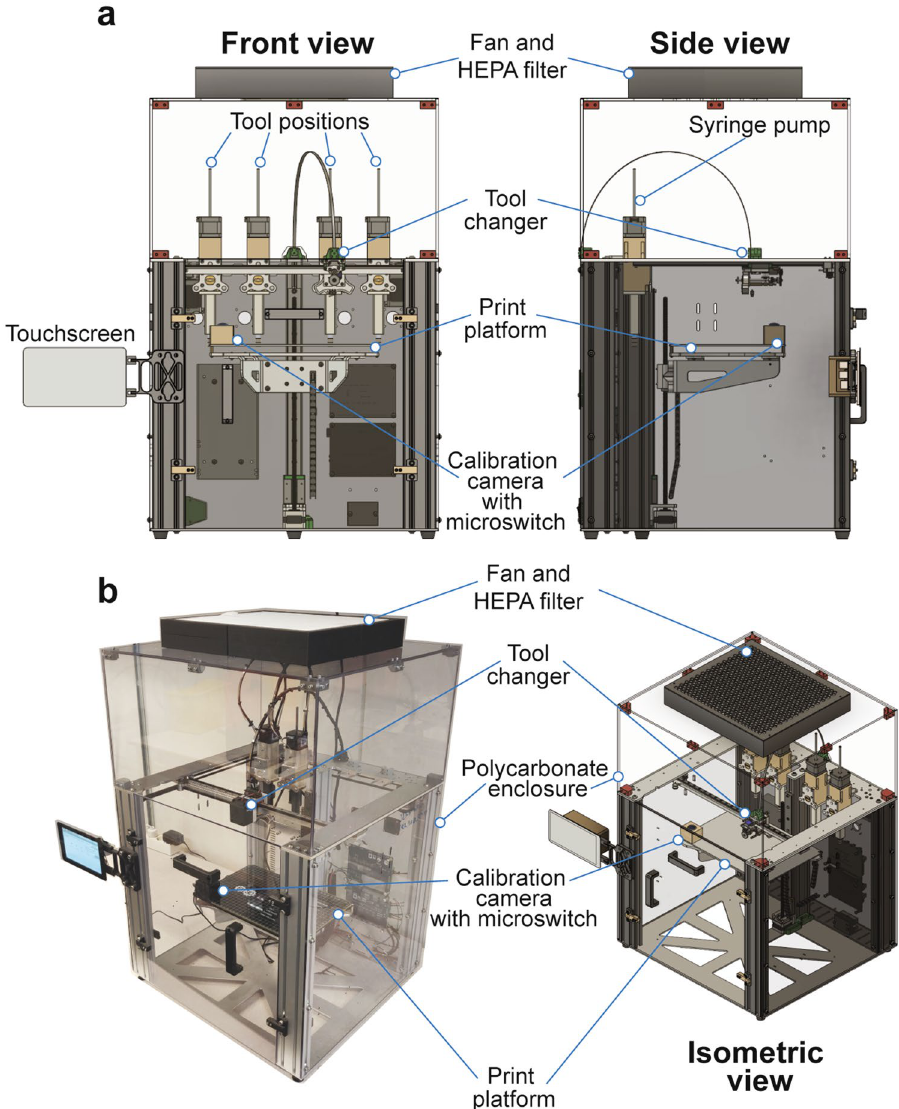
Figure 1. Overview of the open source bioprinter based on the E3D motion system and tool changer. ( a ) Front view and side view CAD illustrations of the open source bioprinter. A transparent polycarbonate box with an integrated HEPA filter with an air intake fan encloses the tool changer to reduce the risk for contamination during the bioprinting process. The tool changer, which is translated along the x- and y-axes, and can retrieve tools from four different tool positions (four syringe pump extrusion tools are shown). The print platform is translated along the z-axis and is equipped with a calibration camera with a microswitch that is used to correct for changes in extrusion position following a change of syringe pump tool. A touch screen attached to the exterior of the cabinet facilitates control of tool selection and calibration functions. ( b ) Isometric views of the open source bioprinter. The left panel presents a photograph of the assembled bioprinter and the right panel presents a CAD